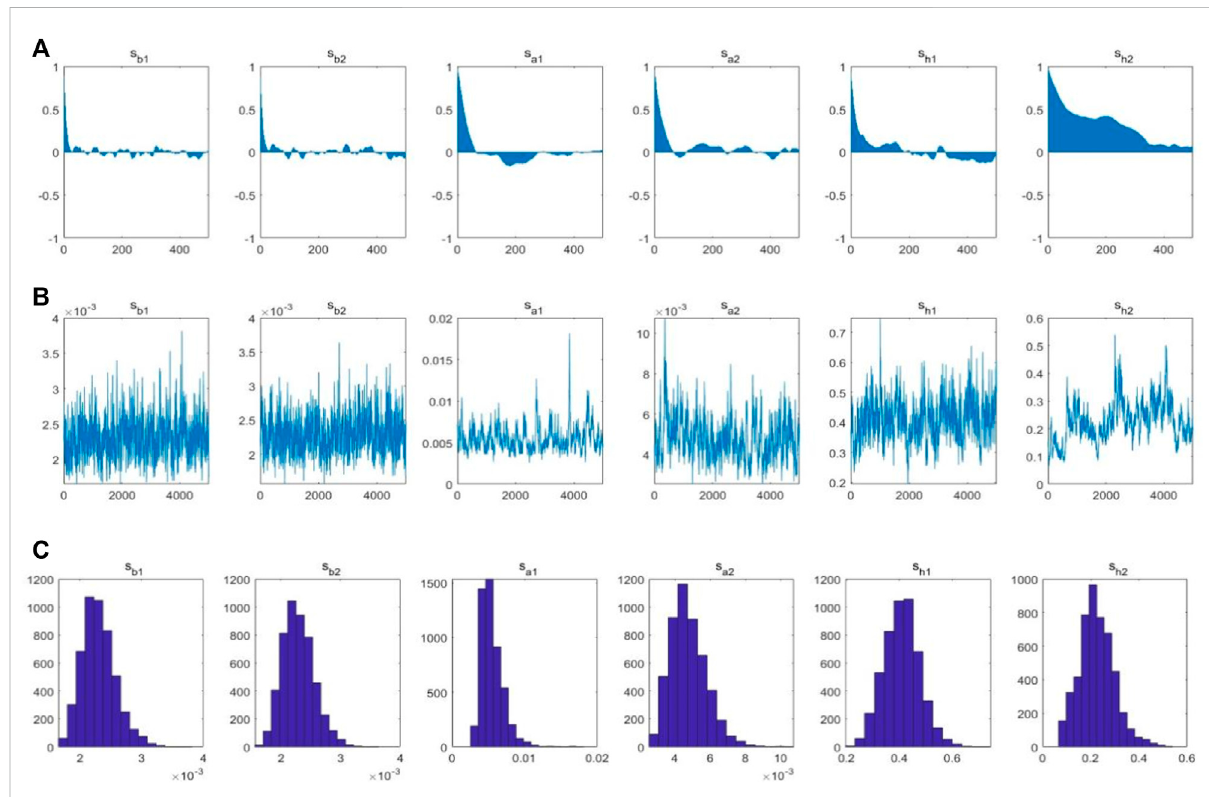
FIGURE 9 Graph of parameter estimation results. (A) The autocorrelation coef fi cient of sampling, (B) dynamic path, and (C) posterior distribution graph.